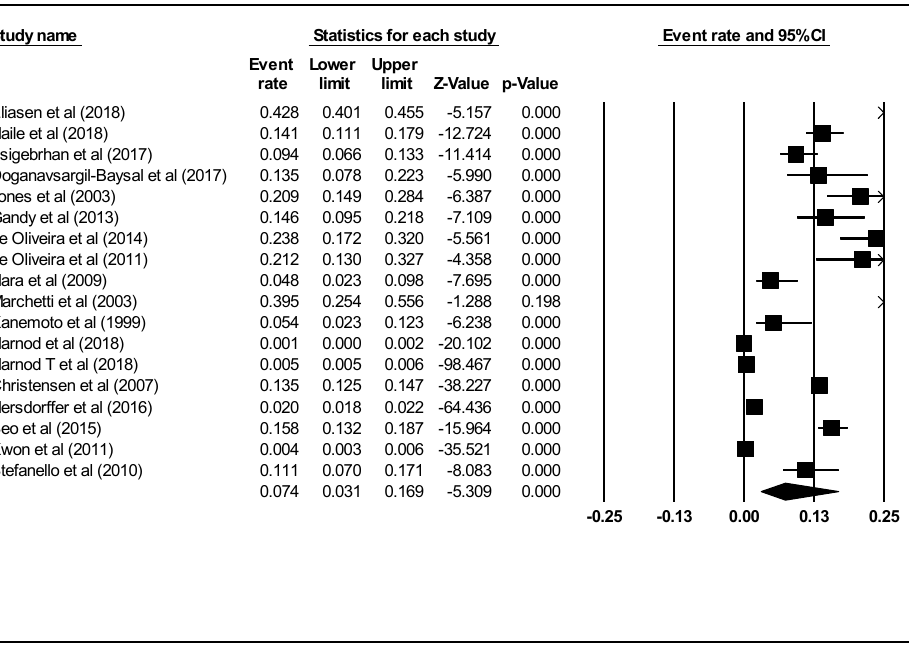
Figure 3. Forest plot of pooled prevalence rate of suicide attempts among PWE.